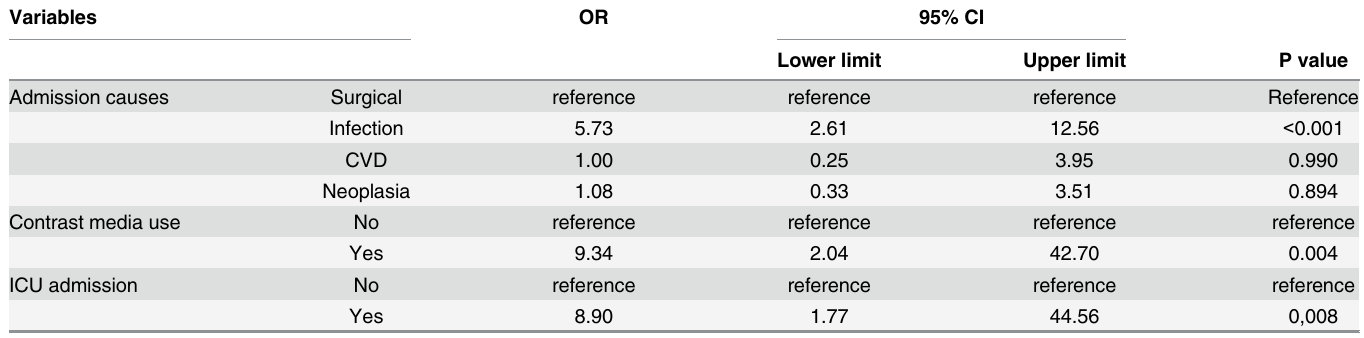
Table 2. Risk factors for acute kidney injury: multivariate analysis.